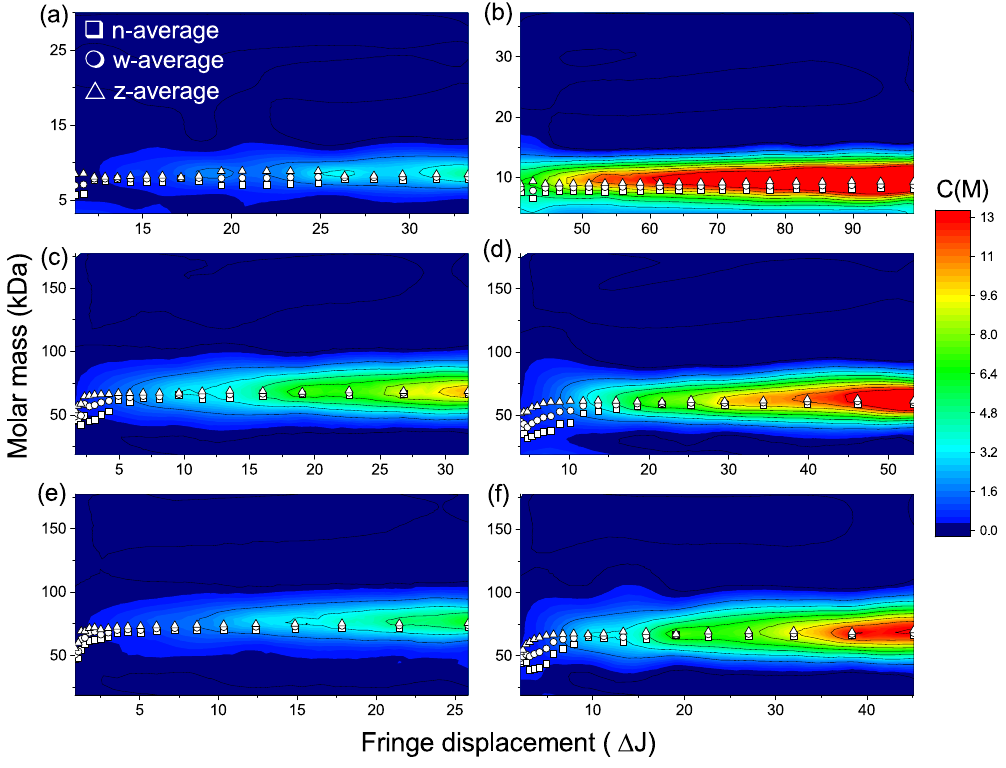
Figure 4. Molar mass as a function of concentration (expressed in fringe displacement units), with number (☐), weight ( ◯ ) and z ( Δ ) averages. Darker contours represent higher proportion of solute in solution. ( a ) IGS; ( b ) IGT; ( c ) IDS 0.1 M; ( d ) IDD 0.1 M; ( e ) IDS 0.2 M; ( f ) IDD 0.2